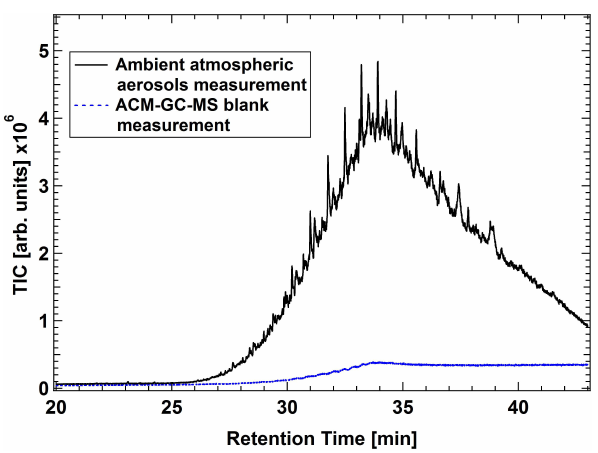
Fig. 8. ACM GC-MS chromatogram of ambient aerosol particles sampled at the Aerodyne Research, Inc. laboratory in Billerica, USA. The blue curve is the blank measurement done after the am- bient aerosol measurement. The rise in the baseline is due to typical GC column bleeding.